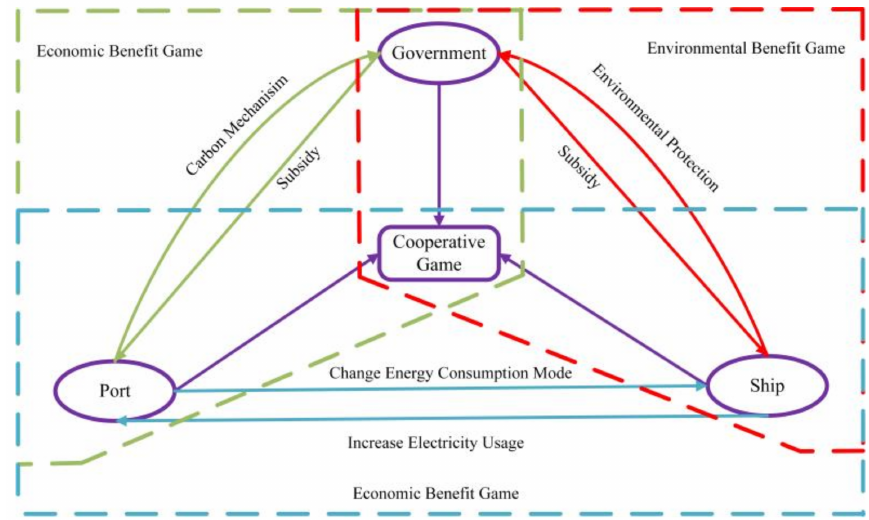
Figure 1. Multiagent game of oil-to-electricity